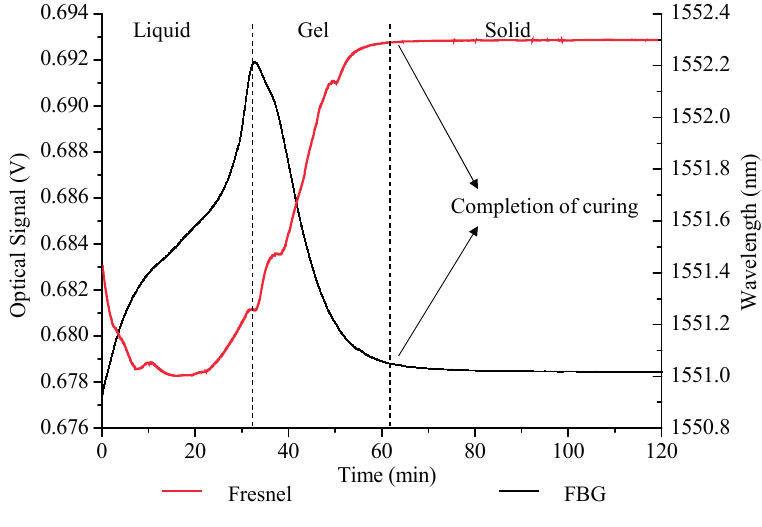
Figure 6. Comparison of Fresnel and FBG signals at 90